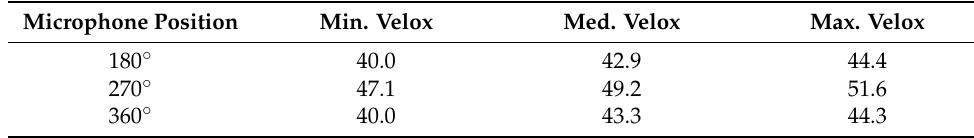
Figure 5. Sound pressure level (dB Lin) measured in the three microphone positions (180 ◦ , 270 ◦ , 360 ◦ ) for the three operating conditions. The fan is positioned at the center with the airflow in the opposite direction to the microphone position 270 ◦ . The * represents the value of SPL at different microphone positions for the three operating conditions. Table 1. Sound pressure level (dB Lin)